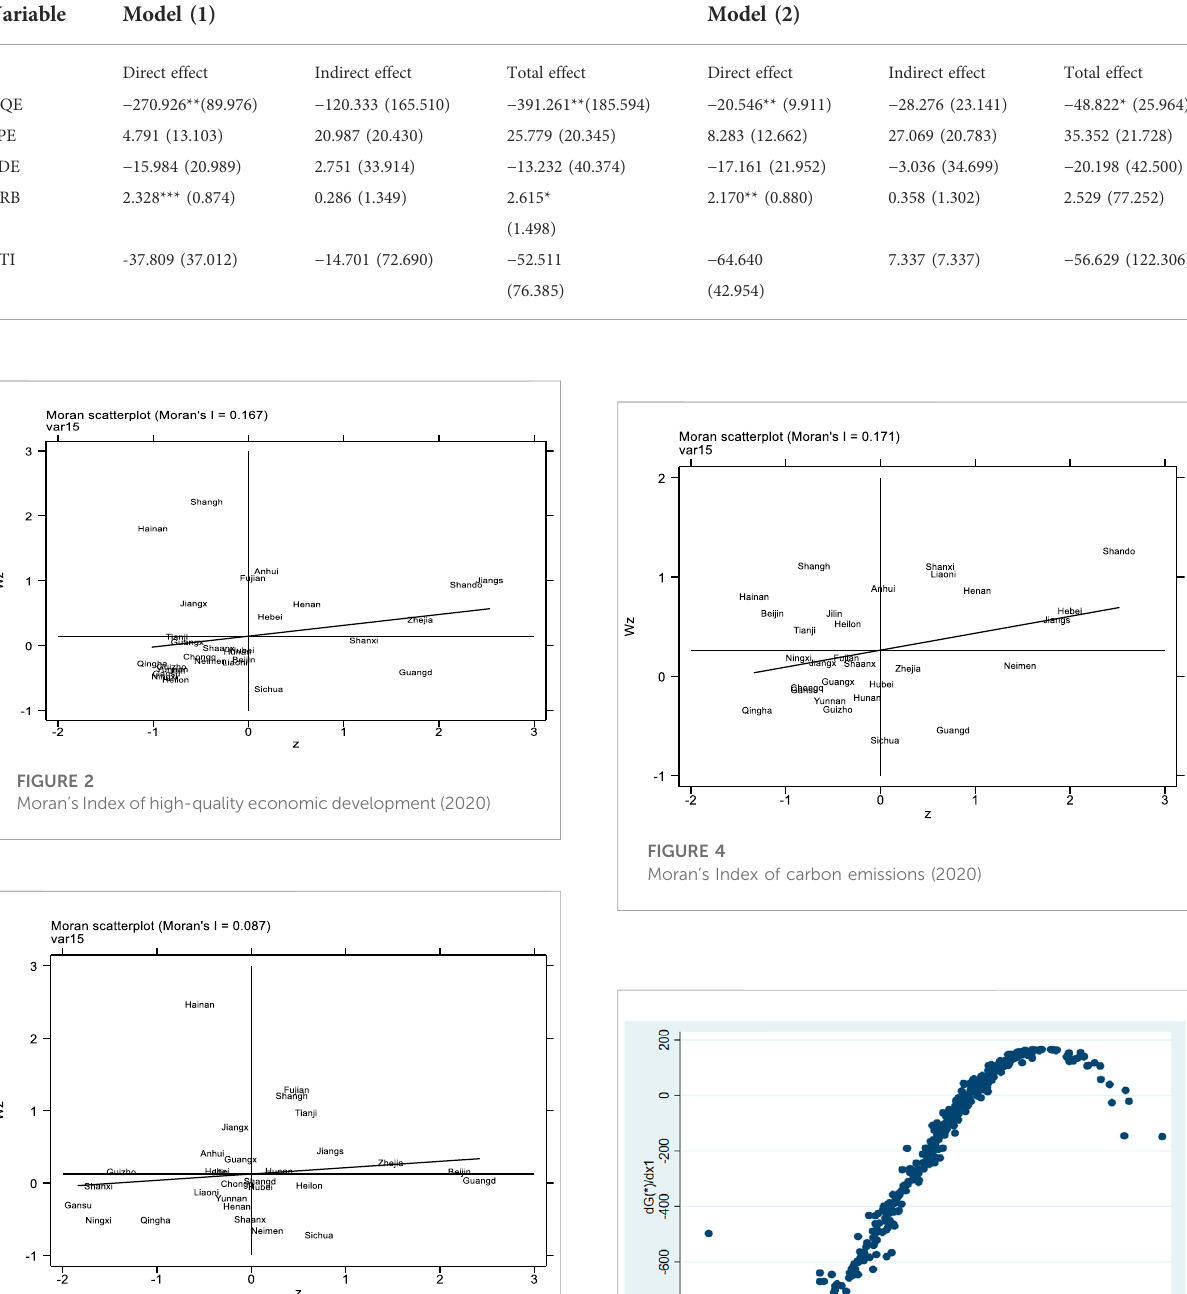
FIGURE 3 Moran ’ s Index of green credit (2020)